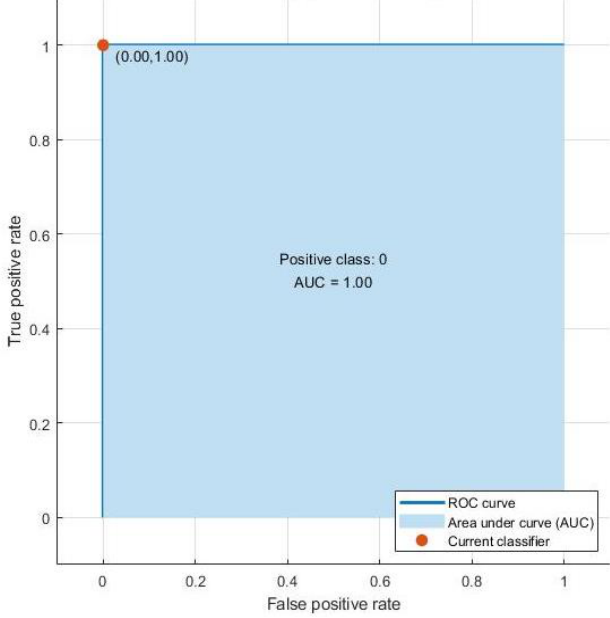
Fig. 5. ROC curve of active